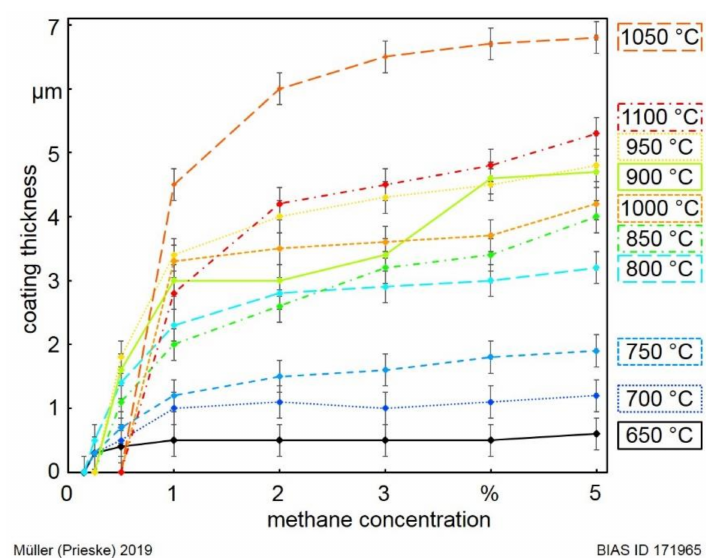
Figure 6. CVD diamond coating thicknesses after 20 min of deposition for di ff erent process temperatures and methane concentrations.